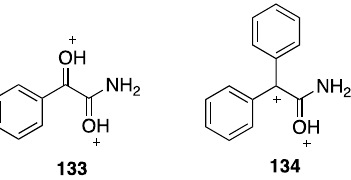
Figure 1. Superelectrophilic activation of arylglyoxamide.